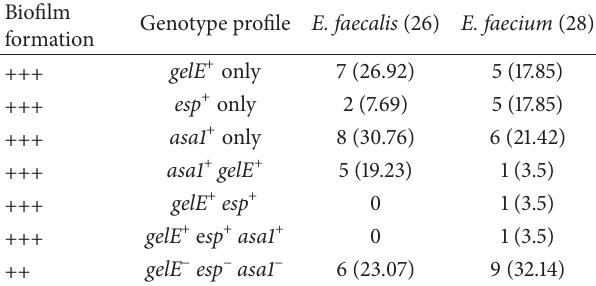
Table 3: Association of biofilm formation with virulence genes.